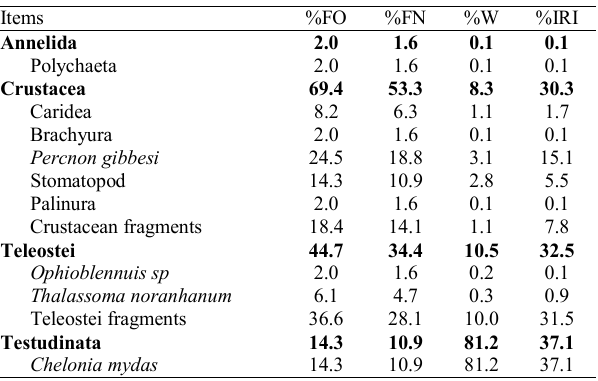
Table 1. Frequency of occurrence (% FO), numerical frequency (% FN), percentage of wet weight (% W) and percentage of relative importance index of food items on gut contents of C. fulva at Trindade Island, Brazil. Bold prints indicate